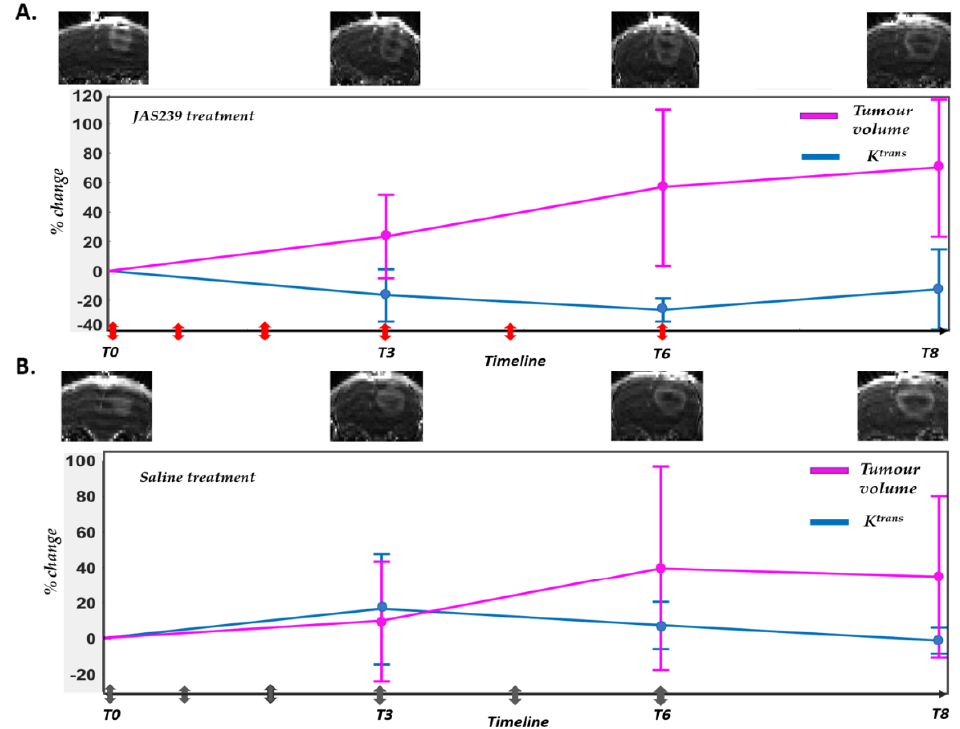
Figure 2. ( A ) T2 weighted images from a JAS239-treated rat acquired on T0 , T3 , T6 , and T8 . Percentage change (with respect to baseline) in volume and mean K trans (obtained using SSM) at respective time points along with points of injections marked with arrows (red) ( B ) T2 weighted images from a saline treated (control) rat acquired on T0 , T3 , T6 , and T8 . Percentage change in volume and mean K trans (obtained using SSM) at respective time points along with points of injections marked with arrows (grey).